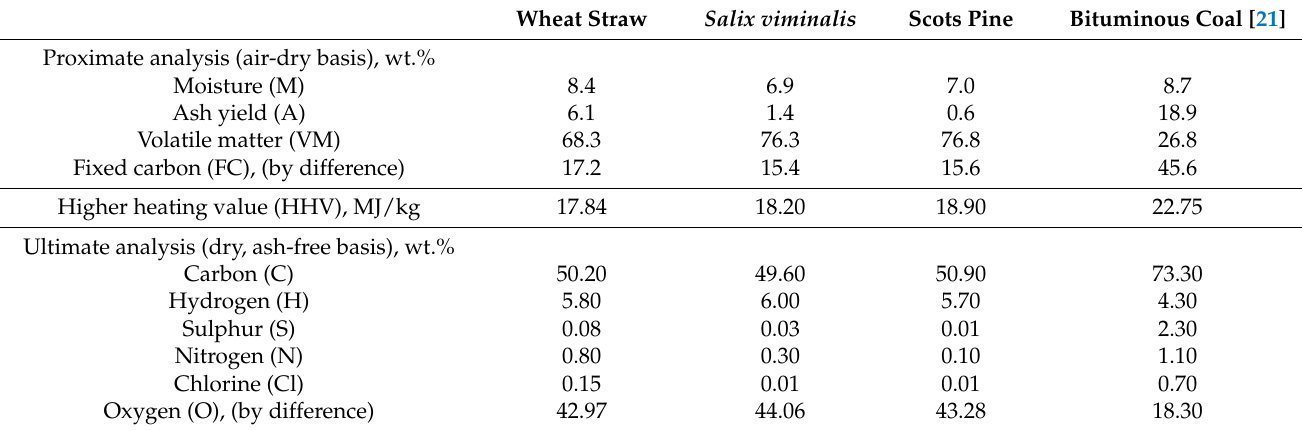
Table 2. Proximate and ultimate and higher heating value of the tested biomass and coal. Wheat Straw Salix viminalis Scots Pine Bituminous Coal